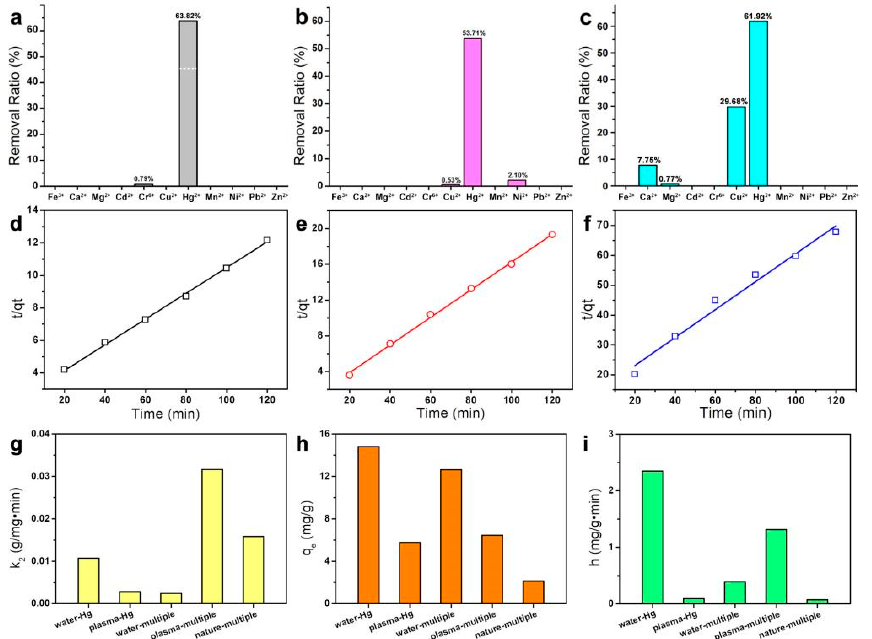
Figure 3. The selectivity for US-N for the removal of 11 multiple metals in ( a ) pure water, ( b ) artifi- cial plasma and ( c ) natural water. Pseudo-second-order kinetic models for US-N to mercury in the removal of 11 multiple metal ions, ( d ) in water, ( e ) in artificial plasma and ( f ) in natural water. The fitting parameters for US-N to Hg 2+ in different systems, Hg 2+ in water, Hg 2+ in artificial plasma, multiple metal ions in water, multiple metal ions in artificial plasma, and multiple metal ions in natural water, ( g ) adsorption rate constant k 2 , ( h ) equilibrium adsorption q e and ( i ) initial sorption rate h .